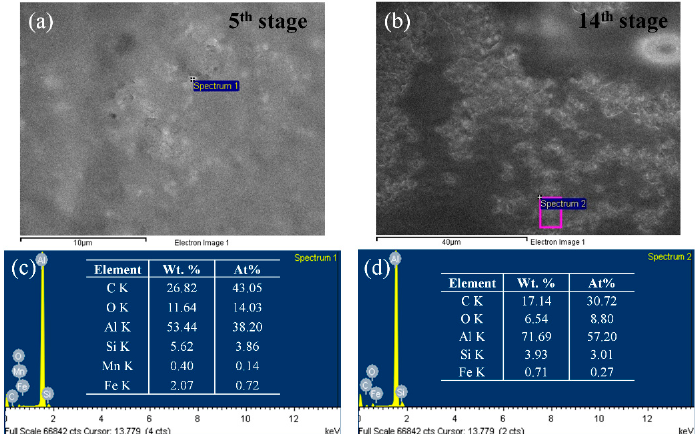
Figure 6. SEM–EDS analysis results of particles collected on ( a , c ) the aluminum foil substrate by ELPI substrate of the 5th stage and the ( b , d ) substrate of 14th stage.